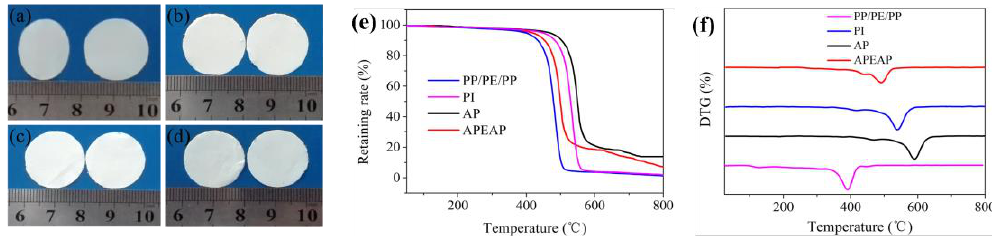
Figure 6. Photograph of separators before and after thermal treatment at 180 °C for 0.5 h: ( a ) PP/PE/PP; ( b ) PI; ( c ) AP; ( d ) APEAP; Thermogravimetric Analysis (TGA) ( e ) and Derivative Thermogravimetry (DTG) ( f ) of various membranes.